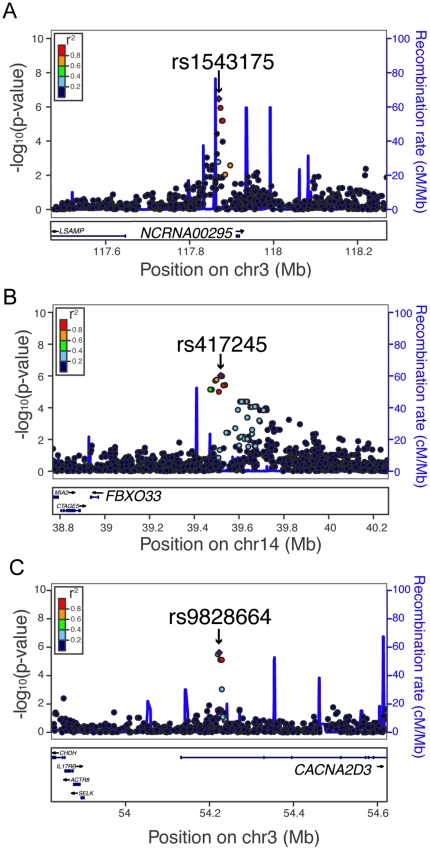
Genomic regions associated with chemotherapeutic-induced cytotoxicity in the ASW population.(A) rs1543175, which is 42 kb upstream of non-protein coding RNA 295 (NCRNA00295), associated with ASW 5′-DFUR AUC (p = 3.4×10−7) and is a trans eQTL in YRI (Table S1). (B) rs417245, which is 546 kb upstream of F-box only protein 33 (FBXO33), associated with ASW 5′-DFUR AUC (p = 9.6×10−7) and the expression of two genes in YRI (Table S1). (C) The SNP rs9828664 in the first intron of calcium channel, voltage-dependent, alpha 2/delta subunit 3 (CACNA2D3) associated with ASW carboplatin IC50 (p = 2.5×10−6) and the expression of two genes in YRI (Table S1). Plots were made with LocusZoom [67] and the color of each dot represents the SNP's linkage disequilibrium r2 in the YRI with the labeled SNP (purple diamond).